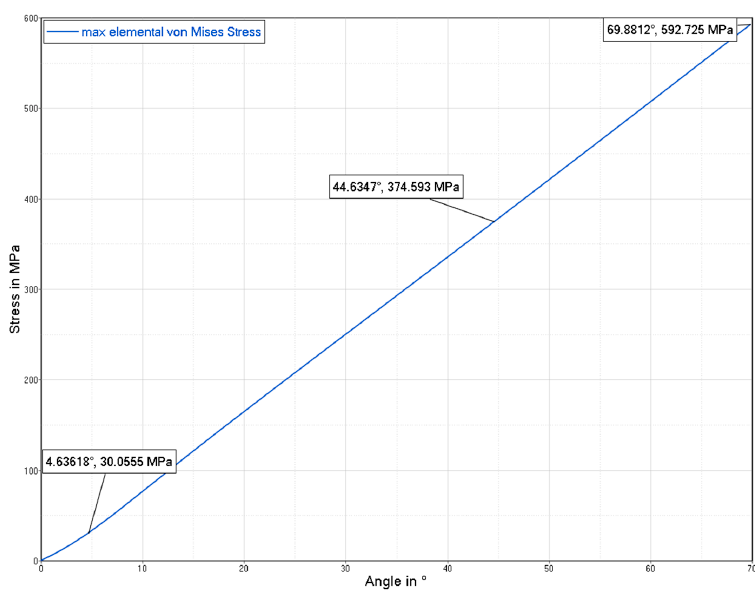
Figure 27. Maximum stress vs. hinge deflection.